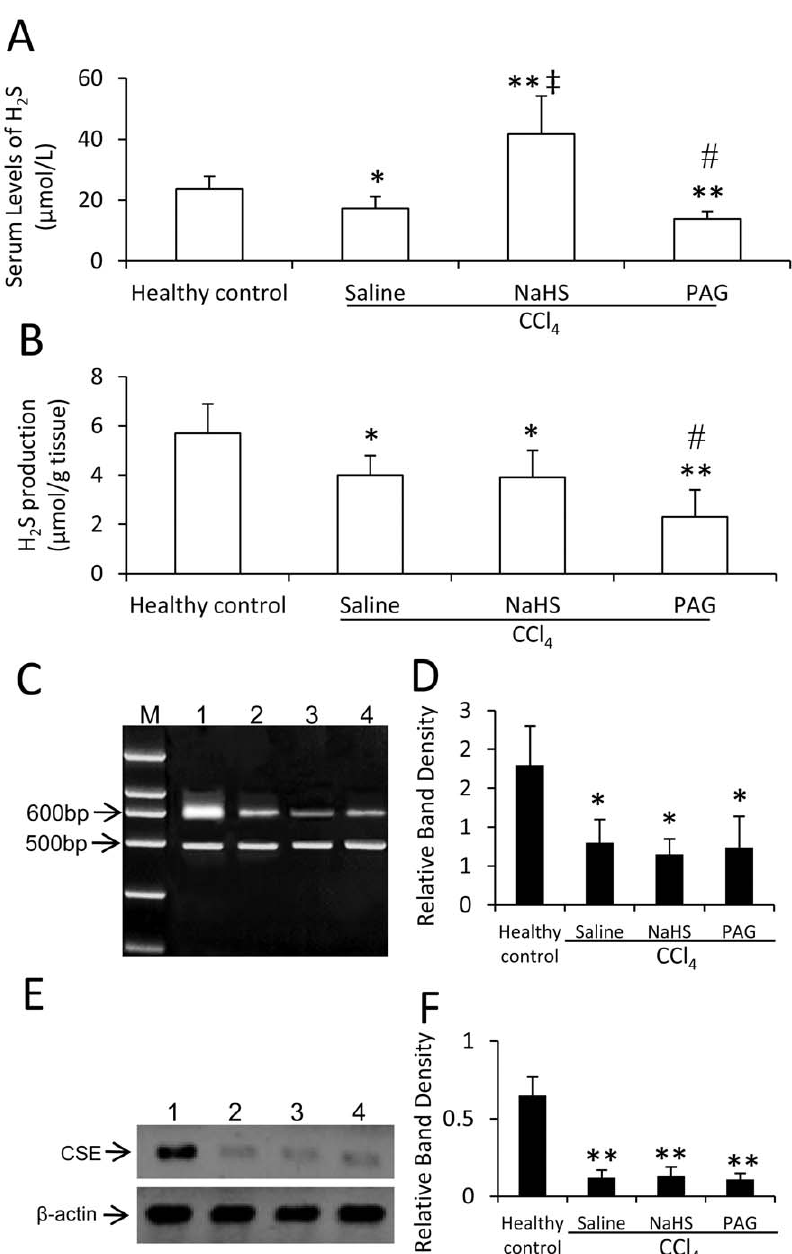
Figure 1. Serum levels of H 2 S, H 2 S production and CSE expression in CCl 4 -induced acute hepatotoxicity. Healthy rats, or CCl 4 -treated rats receiving administrations of saline, NaHS or PAG, were killed 48 h after CCl 4 administration, blood and liver samples were collected. The levels of H 2 S in sera (A) and H 2 S producing activity in livers (B) were measured. (C-F) The expression of CSE mRNA (C, D) and protein (E, F) was detected in liver tissues from healthy rats (lane 1), or CCl 4 -treaed rats receiving administration of saline (lane 2), NaHS (lane 3) or PAG (lane 4), by RT-PCR (C, D) or Western blot analysis (E, F), respectively. M, DNA marker. (D) The density of each band from (C) was measured and compared to that of the internal control, GAPDH. (F) The density of each band from (E) was measured and compared to that of the internal control, b -actin. Results are expressed as mean 6 SD (n=6). Compared to the healthy controls, a significant difference is denoted by ‘‘*’’ , and a highly significant difference by ‘‘**’’ (P , 0.001). Compared to rats treated with CCl 4 + saline, a significant increase is denoted by ‘‘ { ’’, and a significant reduction is denoted by ‘‘ # ’’. doi:10.1371/journal.pone.0025943.g001 before completion of the experiment, and were excluded from the were even lower at week 8 and 12 than that at week 4 (Fig. 2A). study. Blood samples were collected at indicated time points to However, NaHS significantly (P , 0.05) elevated the serum level of measure the serum levels of H 2 S in rats. The healthy rats had a H 2 S at week 4 after CCl 4 administration in CCl 4 -induced cirrhotic stable serum level of H 2 S, while the H 2 S levels in CCl 4 -induced rats, compared with saline, and serum H 2 S was maintained at a cirrhotic rats receiving injection of saline declined at week 4 after higher level at week 8 and 12 (Fig. 2A). Administration of PAG CCl 4 administration, and continued dropping as the H 2 S levels resulted in significantly (All P , 0.05) lower serum levels of H 2 S in